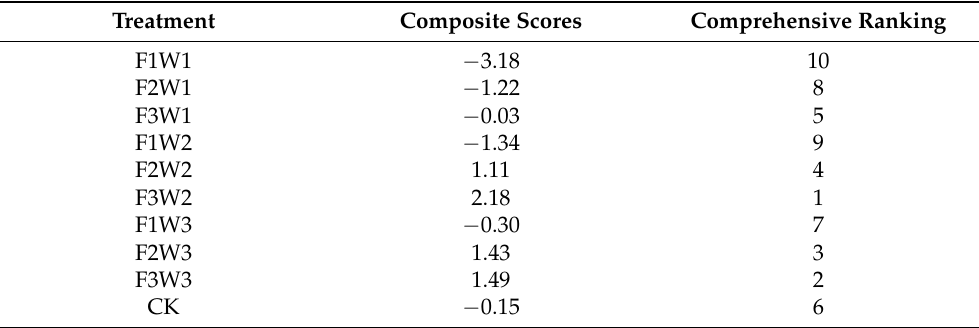
Table 9. Principal component scores and comprehensive evaluation under different volumes and methods of